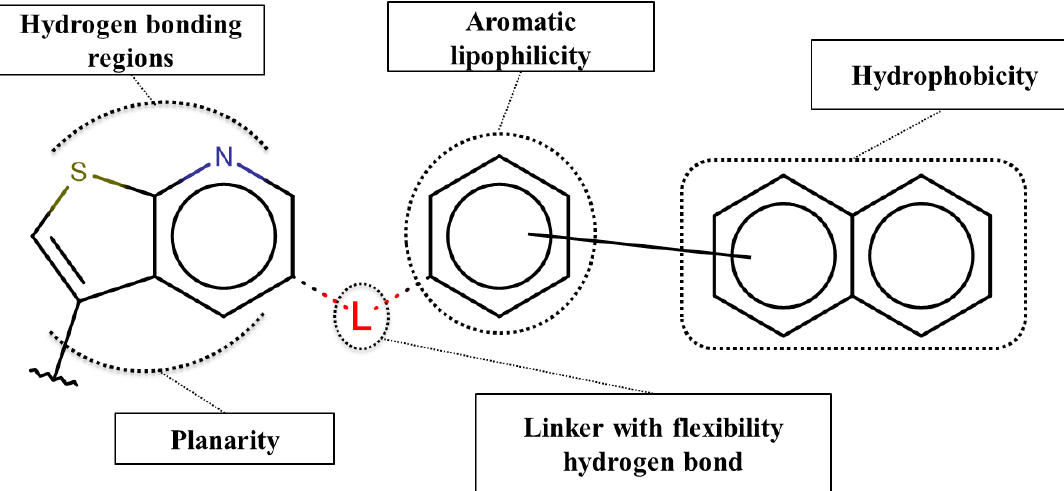
Figure 5. SAR maps derived from the analysis of the physico-chemical descriptors and the structural features of the molecules in the training set.